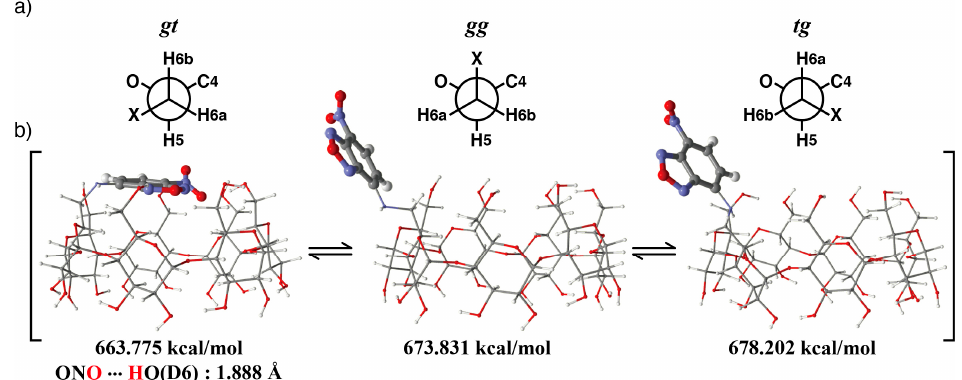
Figure 7. Estimated conformational equilibrium of NC0 β CD in the gt , gg , and tg conformers. ( a ) Three kinds of conformers about the C5-C6 bond, ( b ) Estimated structures of NC0 β CD in the gt , gg , and tg conformers.